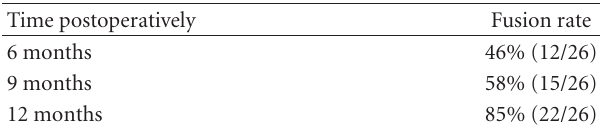
Table 2: XLIF fusion rates.